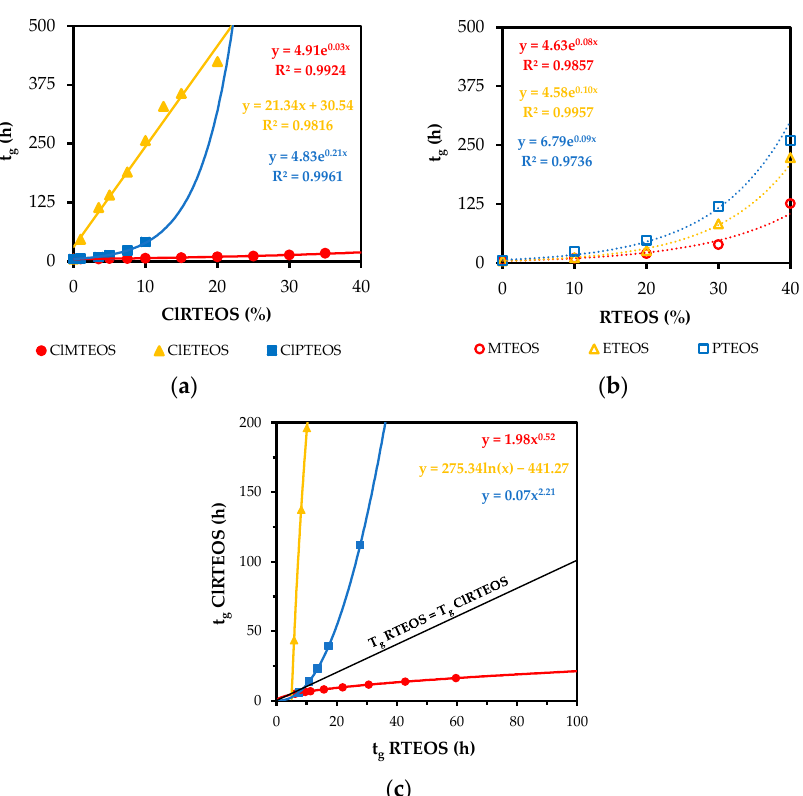
Figure 1. ( a ) t g as a function of the percentage of precursor in the TEOS:ClRTEOS series, ( b ) t g as a function of the percentage of t precursor in the TEOS:RTEOS series, and ( c ) t g of the ClRTEOS versus RTEOS series.